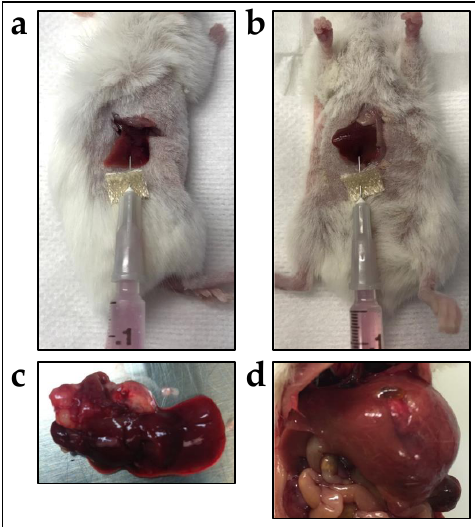
Figure 1. Injection of HepG2 and Huh-6 HB cells into the mouse liver to generate xenograft tumors. ( a , b ) Cells were injected either into the right median lobe ( a ) or the left lateral lobe ( b ). ( c , d ) Representative gross tumors generated with injection of Huh-6 cells into the right median lobe (c) or HepG2 cells into the left lateral lobe ( d ). From Woodfield et al., 2017 [19].